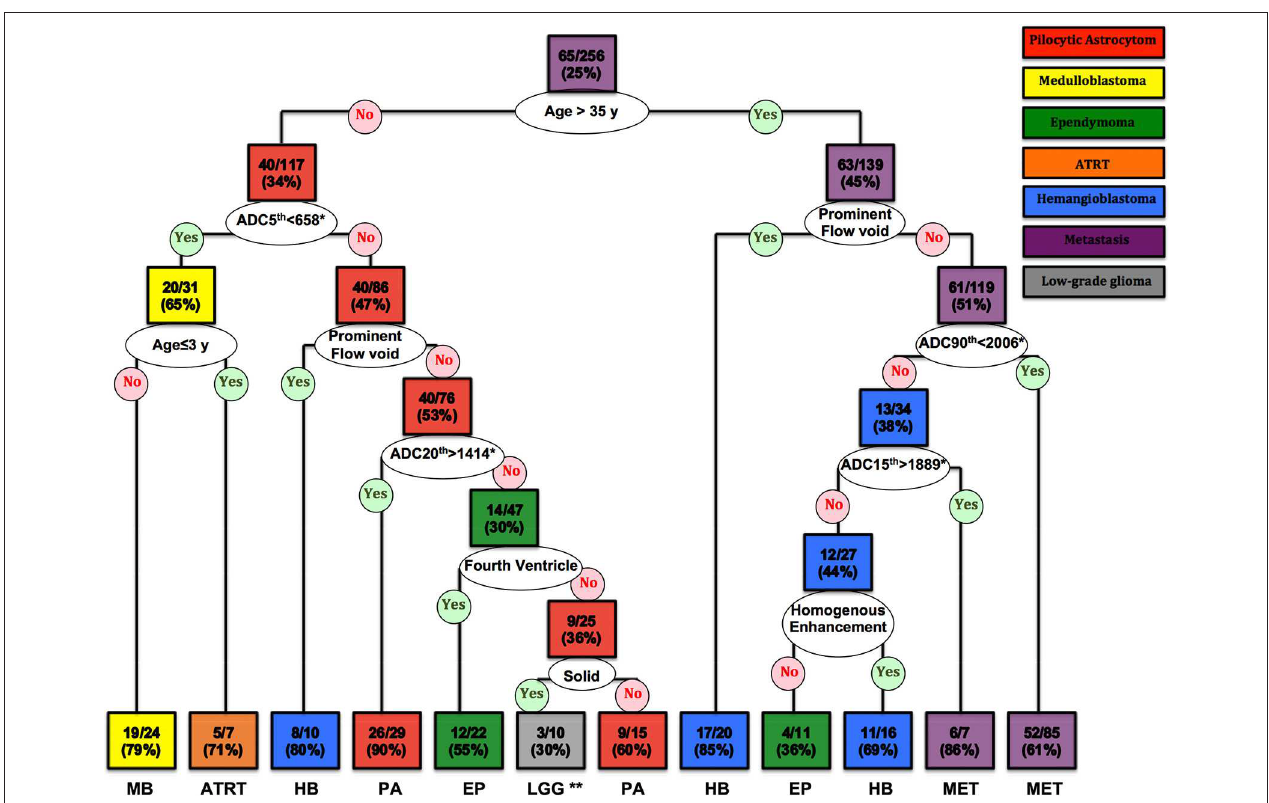
FIGURE 5 | The CART decision tree model could differentiate 7 histopathologies among posterior fossa tumors. In each box (node/leaf), the accurate classification rate (positive predictive value) is expressed as ratios of the most common tumor type per total number of cases fulfilling the criteria. Each box is colored to represent the tumor type, and the intensity of the color reflects the accurate classification ratio. ADC, apparent diffusion coefficient; ATRT, atypical teratoid/rhabdoid tumors; CART, Classification and Regression Tree; EP, Ependymoma; HB, Hemangioblastoma; LGG, low-grade glioma/astrocytoma; MET, metastases; MB, Medulloblastoma; PA, pilocytic astrocytoma. *The ADC n th refers to the ADC histogram n th percentile value × 10 − 6 mm 2 /s; for example, ADC 5th percentile < 658 × 10 − 6 mm 2 /s. **Both low-grade glioma and anaplastic astrocytoma had 3/10 (30%) ratios in this terminal